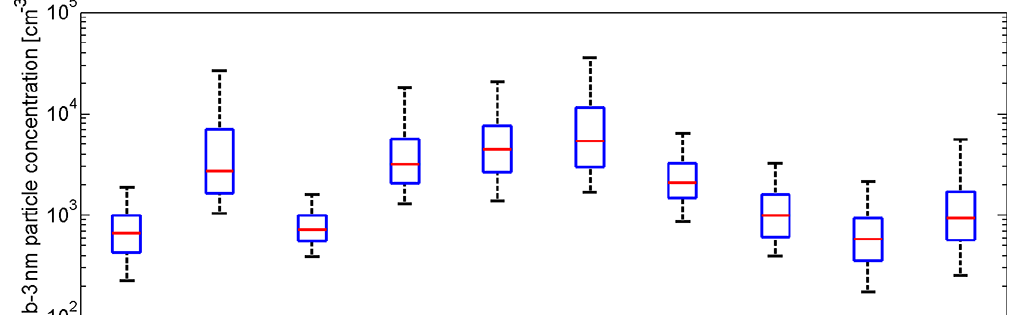
Figure 3. Sub-3nm particle concentrations in Hyytiälä during different measurement campaigns. The red lines show the medians, the blue boxes indicate the 25th and 75th percentiles, and the vertical bars show the 5th and 95th percentiles. Note that the data from 2015–2016 are divided into different seasons: summer (sum), autumn (aut), winter (wint), and spring (spr). Table 2. Medians of sub-3nm particle concentration, the ratio of ion concentration to the total sub-3nm particle concentration, sulfuric acid concentration, condensation sink, and the frequency of new particle formation (NPF) events at different measurement sites. Sulfuric acid concentration is estimated from a proxy for all other campaigns except those that are marked with an asterisk ( ∗ ). The explanations for abbreviations, the measurement periods and the exact size ranges for particle measurements are shown in Table 1. Data from Hyytiälä